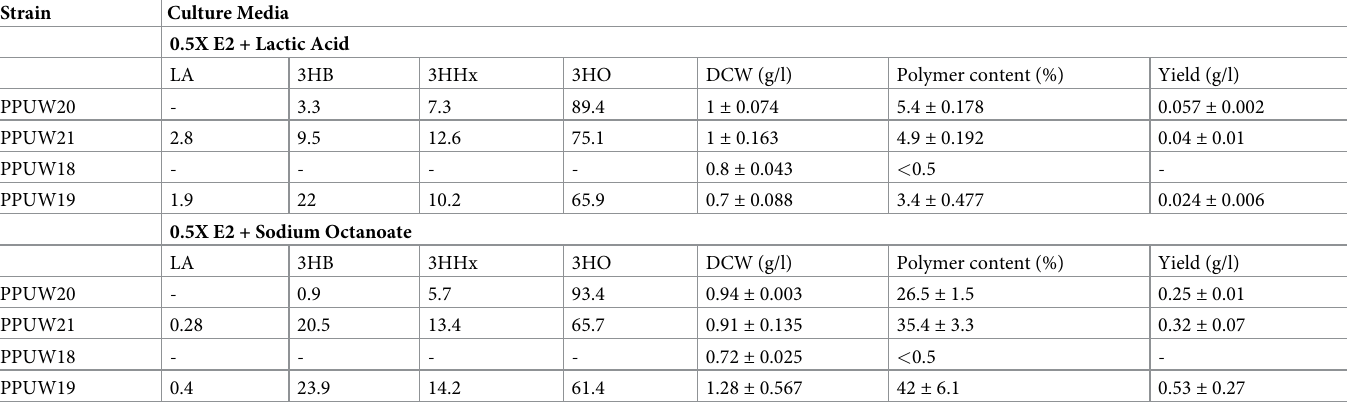
Table 3. PHA copolymer production in P . putida harboring pTAM and control plasmid vector. Strain Culture